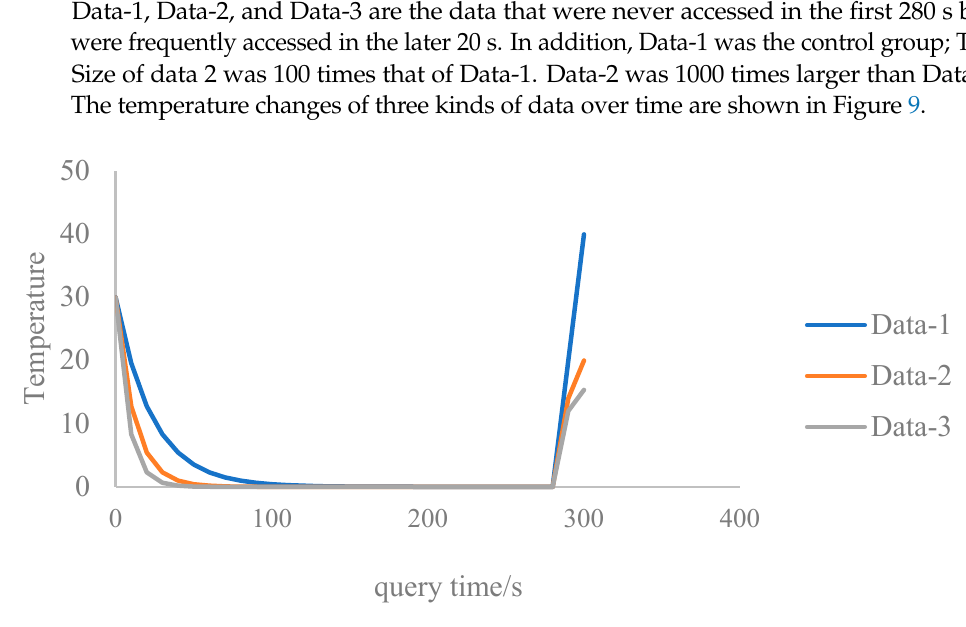
Figure 9. Influence of Size on temperature in S-TCR method.